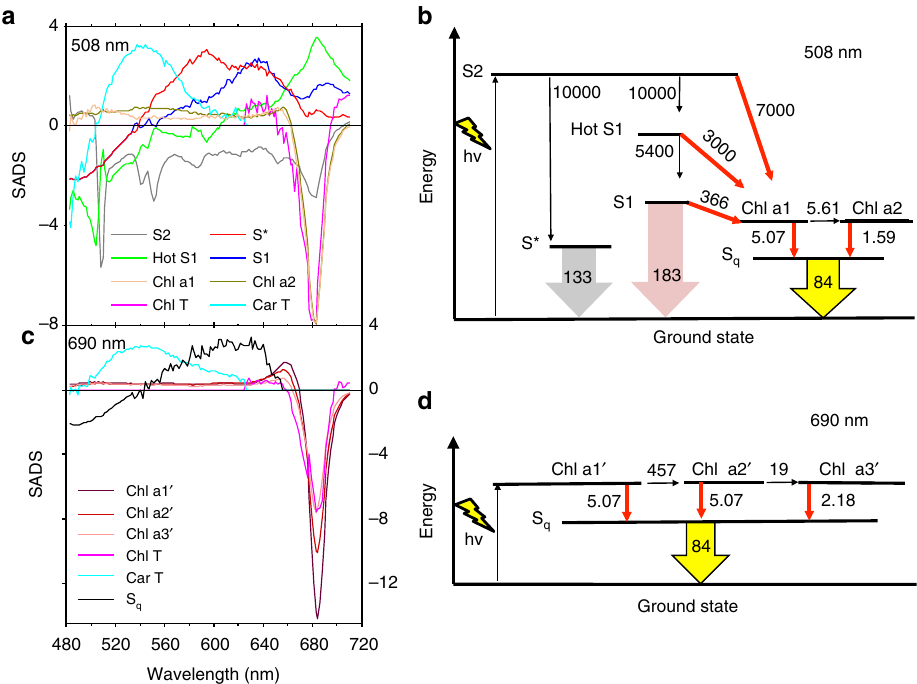
Fig. 3 Target models of the excited state dynamics in LHC – Asta after Car (508 nm) and Chl (690 nm) excitations. a SADS estimated from the kinetic model for Car excitation (508 nm) shown in b . Spectrum and lifetime of S q have been constrained to be the same for both models and for clarity the associated SADS is not shown in a . c SADS estimated from the kinetic model for 690 nm excitation shown in d . In b and d , red arrows indicate the direction of EET between the various pigments. SADS of the Car and Chl triplet states (Chl T and Car T) are assumed to be zero above 630 nm and below 630 nm, respectively. The numbers next to the arrows in b and d are rates in ns − 1 . For clarity, the components describing unconnected astaxanthin in b , and the formation of Chl T and Car T states are not shown in b . and d . The full target models are shown in Supplementary Figure